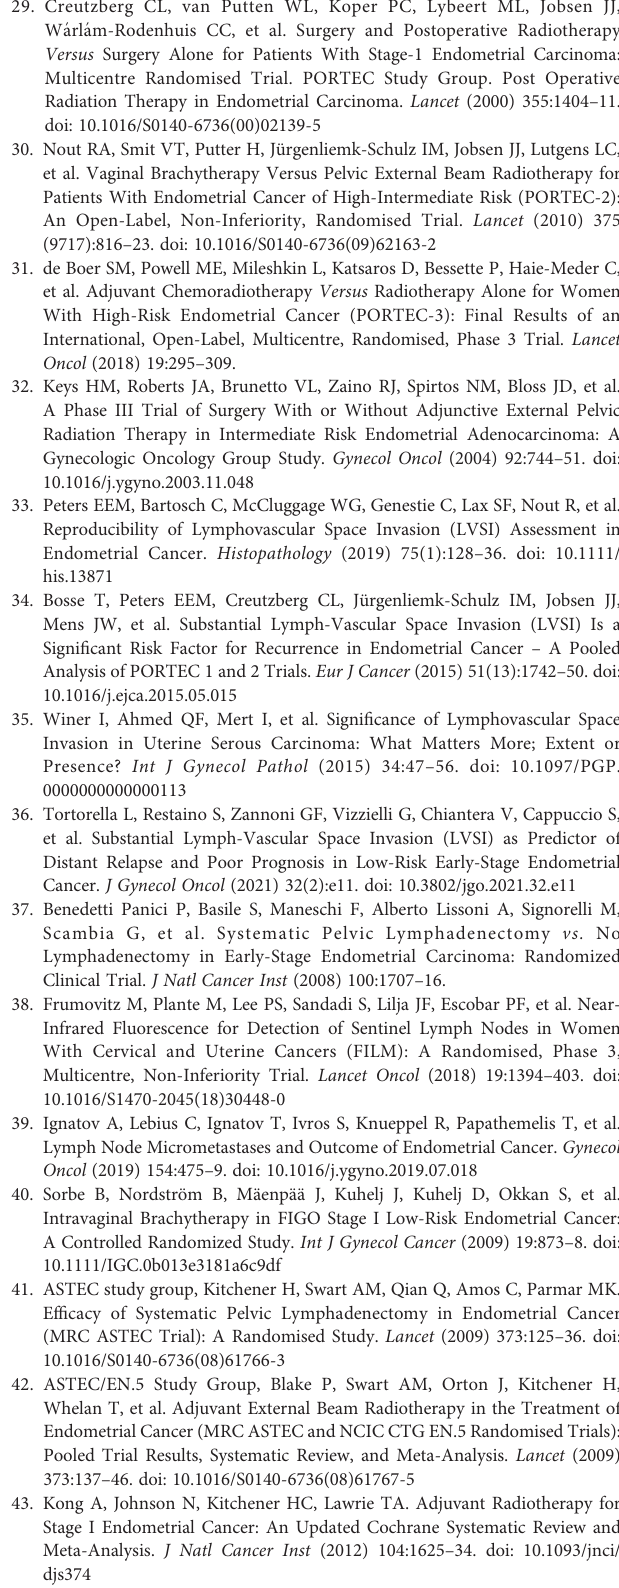
FIGO Stage IA-IB. Anticancer Res (2019) 39(1):421 – 4. doi: 10.21873/